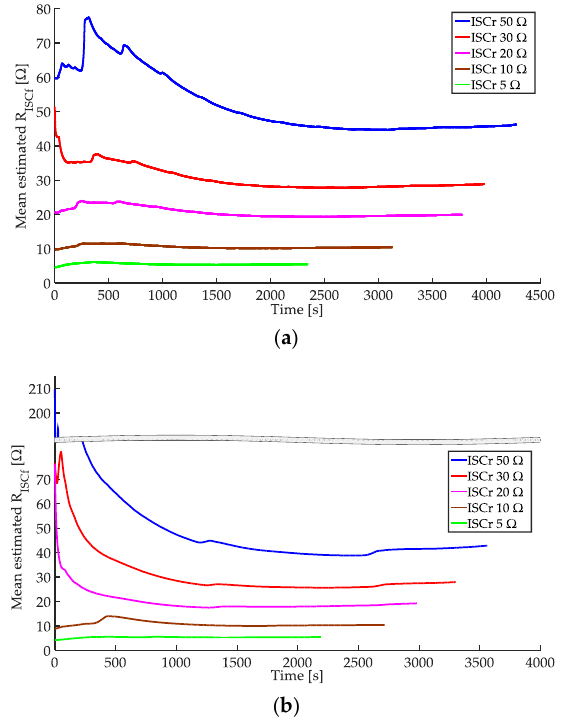
Figure 9. 𝑅 𝐼𝑆𝐶𝑓 ̅̅̅̅̅̅̅ in the simulation model with ISCr 50, 30, 20, 10 and 5 Ω: ( a ) DST 5 A; ( b ) UDDS 5